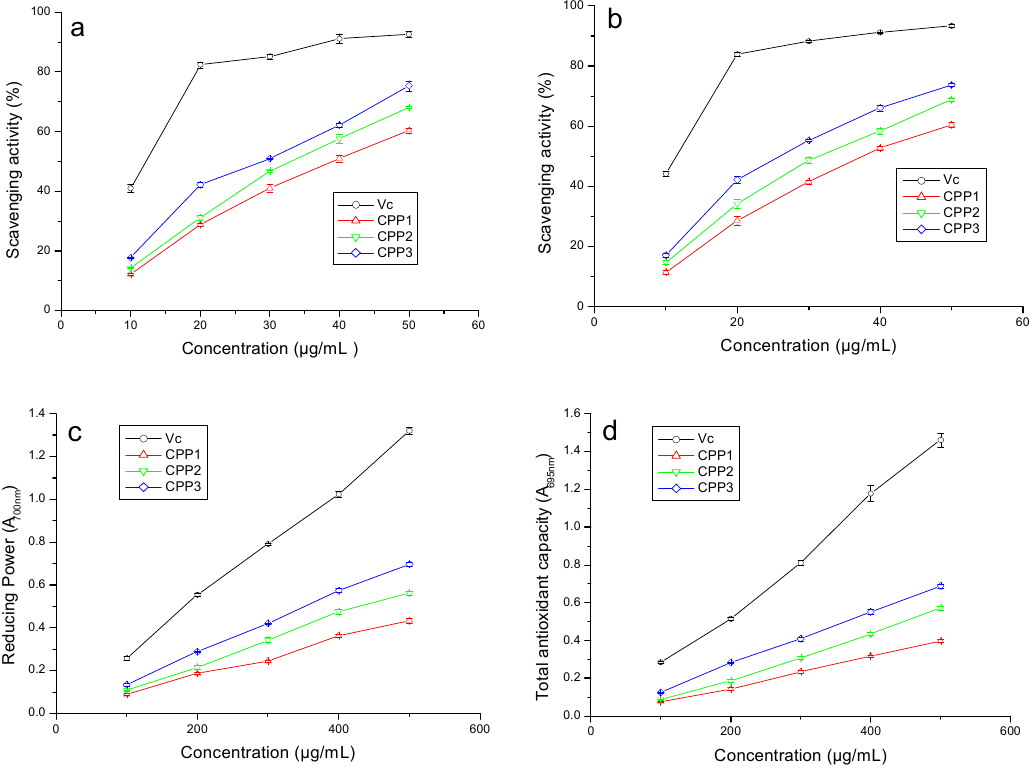
Figure 7. Antioxidant activities of CPP1, CPP2, and CPP3 scavenging of DPPH radical ( a ); scavenging of ABTS radical ( b ); reducing power ( c ); and total antioxidant activity ( d ).